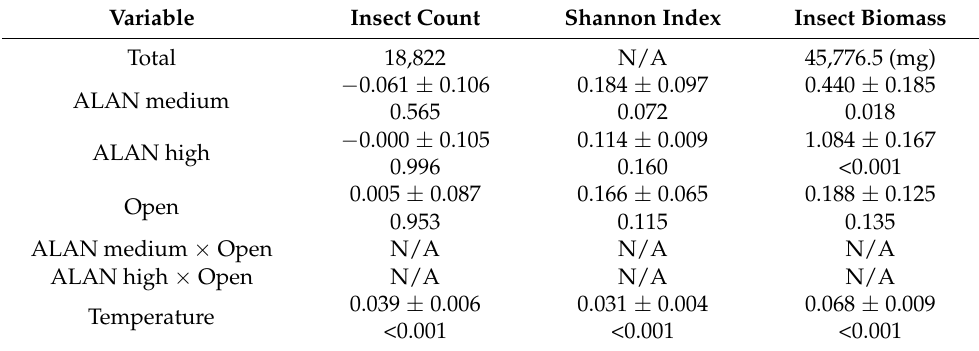
Table 1. General linear models results (regression estimate ± standard error on top, p value at bottom, n = 204) on insect variables in relation to ALAN, spatial complexity, and temperature. Variable Insect Count Shannon Index Insect Biomass Total 18,822 N/A 45,776.5 (mg) − 0.061 ± 0.106 0.184 ± 0.097 0.440 ± 0.185 ALAN medium 0.565 0.072 0.018 − 0.000 ± 0.105 0.114 ± 0.009 1.084 ± 0.167 ALAN high 0.996 0.160 <0.001 0.005 ± 0.087 Open 0.135 ALAN medium × Open N/A N/A N/A ALAN high × Open N/A N/A N/A 0.039 ± 0.006 0.031 ± 0.004 0.068 ± 0.009 Temperature <0.001 <0.001